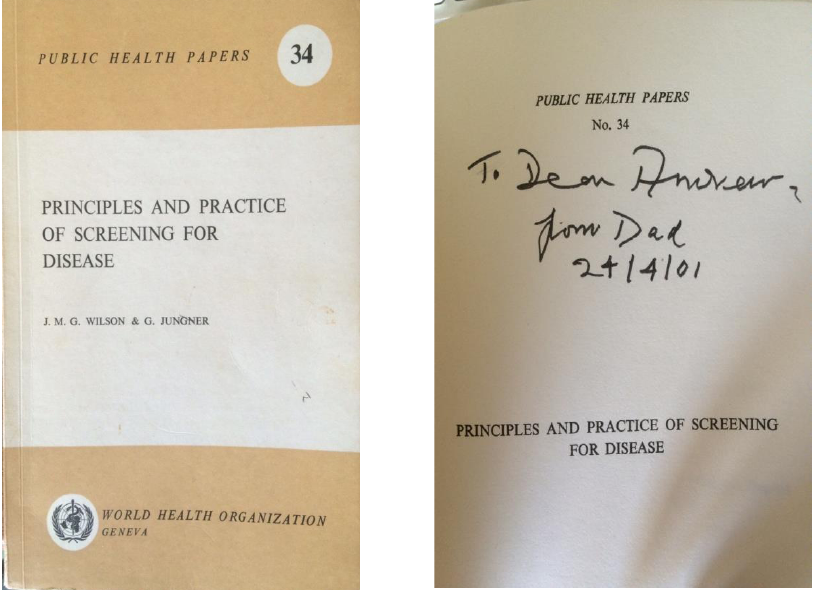
Figure 1. J.M.G. Wilson’s personal copy given to his eldest son Andrew.